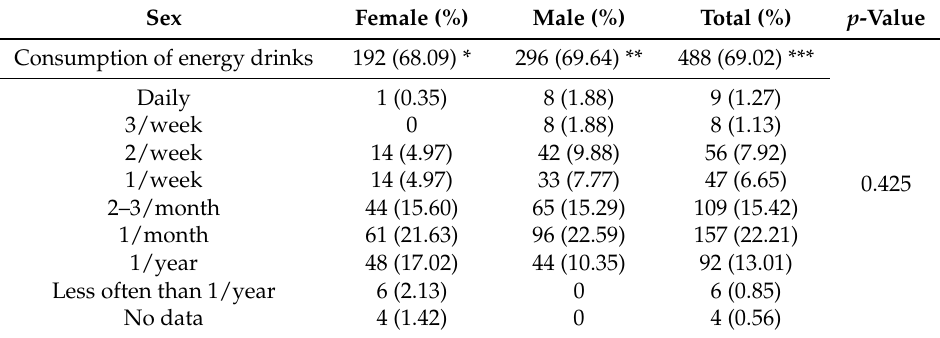
Table 2. Energy drinks (EDs) consumption by adolescent athletes.